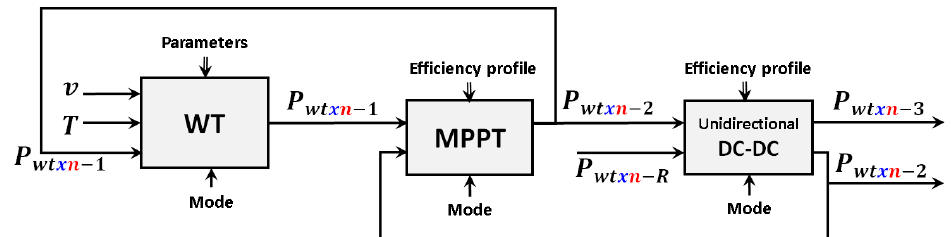
Figure 3. Block diagram of the programmed model of WTG.